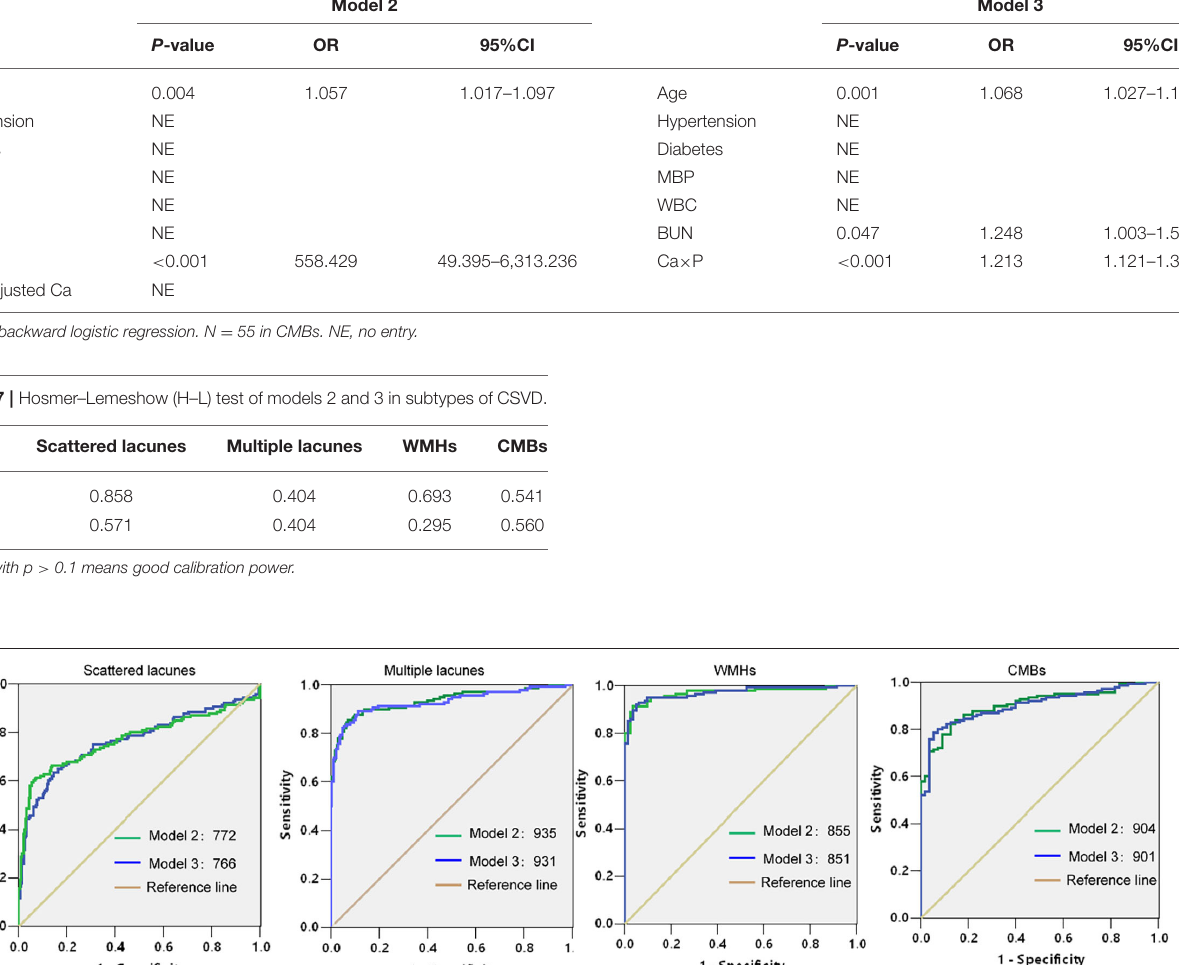
Frontiers in Nutrition |